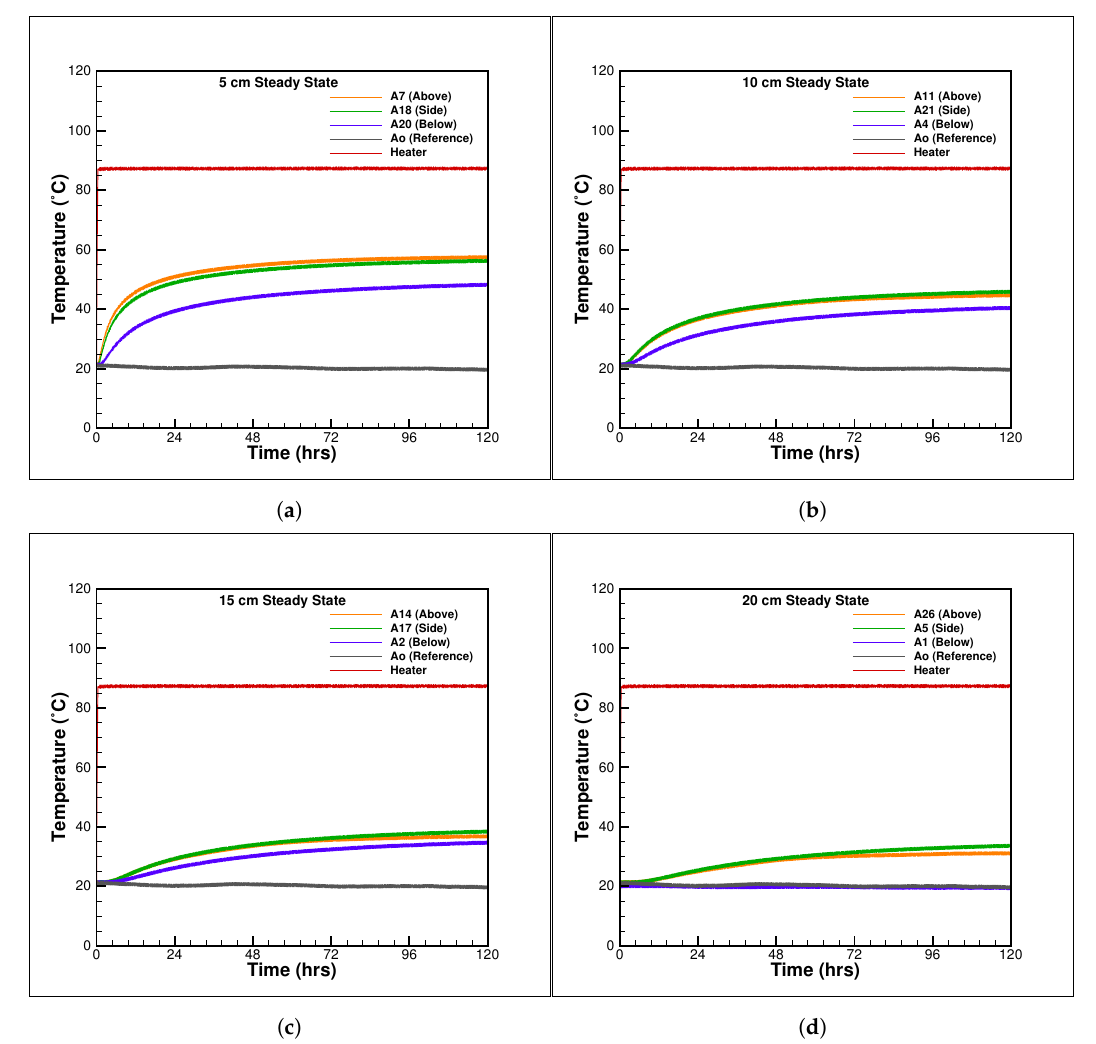
Figure 7. Temperature plot with 5 days constant temperature heating of 90 °C of thermocouples at ( a ) 5 cm; ( b ) 10 cm; ( c ) 15 cm; ( d ) 20 cm from the heater